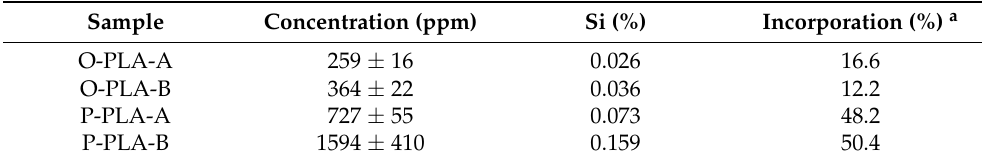
Table 3. Chemical analyses of functionalized PLA flat tapes determined by